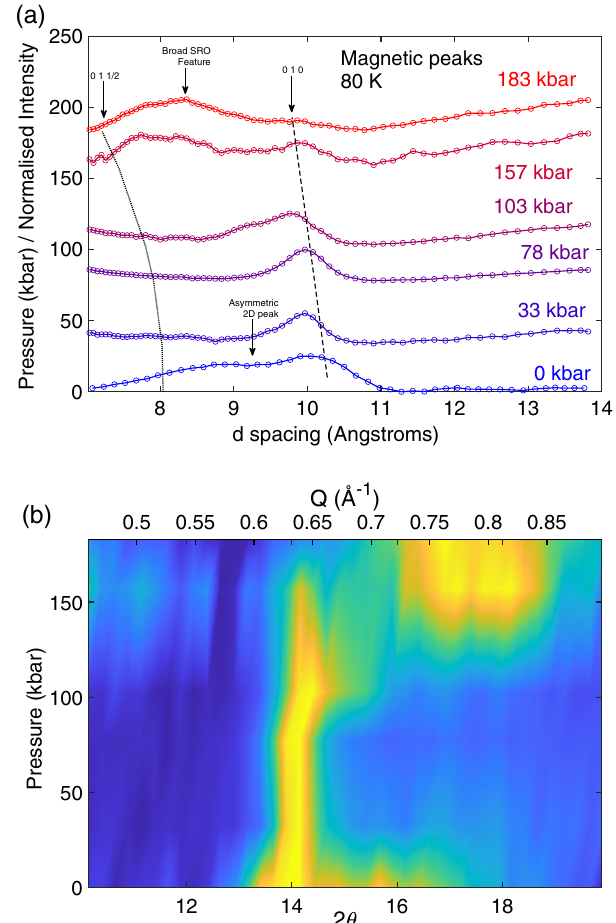
FIG. 8. (a) Magnetic peaks and features at 80 K for pressure points taken in sintered diamond cell on D20, ILL. The data are normalized and their vertical intercept set to their corresponding pressure values. The pressure-dependent d spacings of the 0 1 0 and 0 1 1 magnetic peak positions, extrapolated from the lattice 2 parameters previously found for each pressure and indexed in the monoclinic space group, are shown as dashed and dotted lines, respectively. (b) Heat map of magnetic peaks at 80 K for sintered diamond pressures — color represents normalized intensity. At ambient pressure, the magnetic order is characterized by an asymmetric feature of both 0 1 0 and 0 1 1 contributions. This 2 feature then sharpens into a sharp 0 1 0 peak only by 20 kbar. The HP-I to HP-II structural transition can be seen around 150 kbar, which alters the magnetic state into a broad feature at higher Q which persists above room